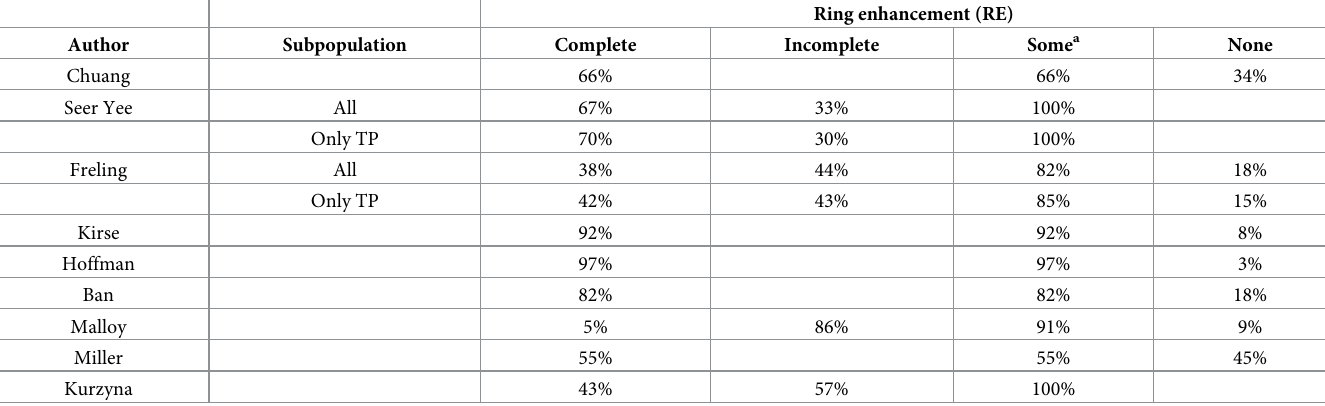
Table 2. Prevalence of rim enhancement (RE) of abscesses in studies that had reported on RE.